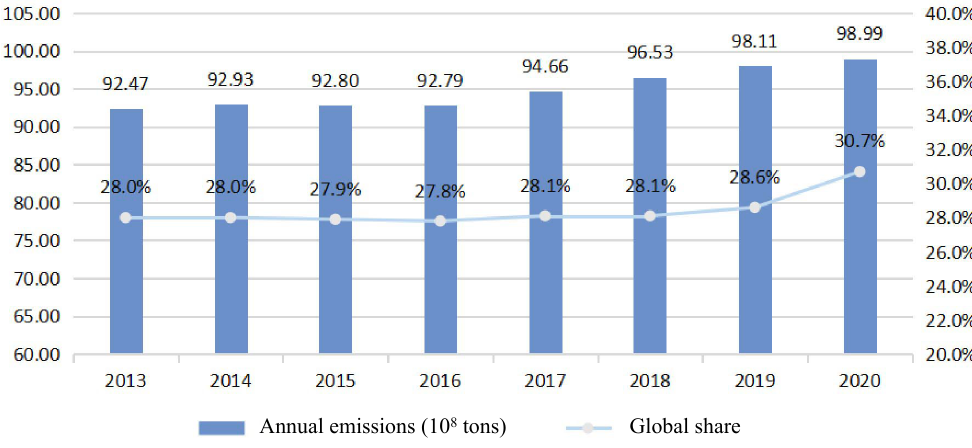
Figure 1. Development trend of carbon emission in China in recent years